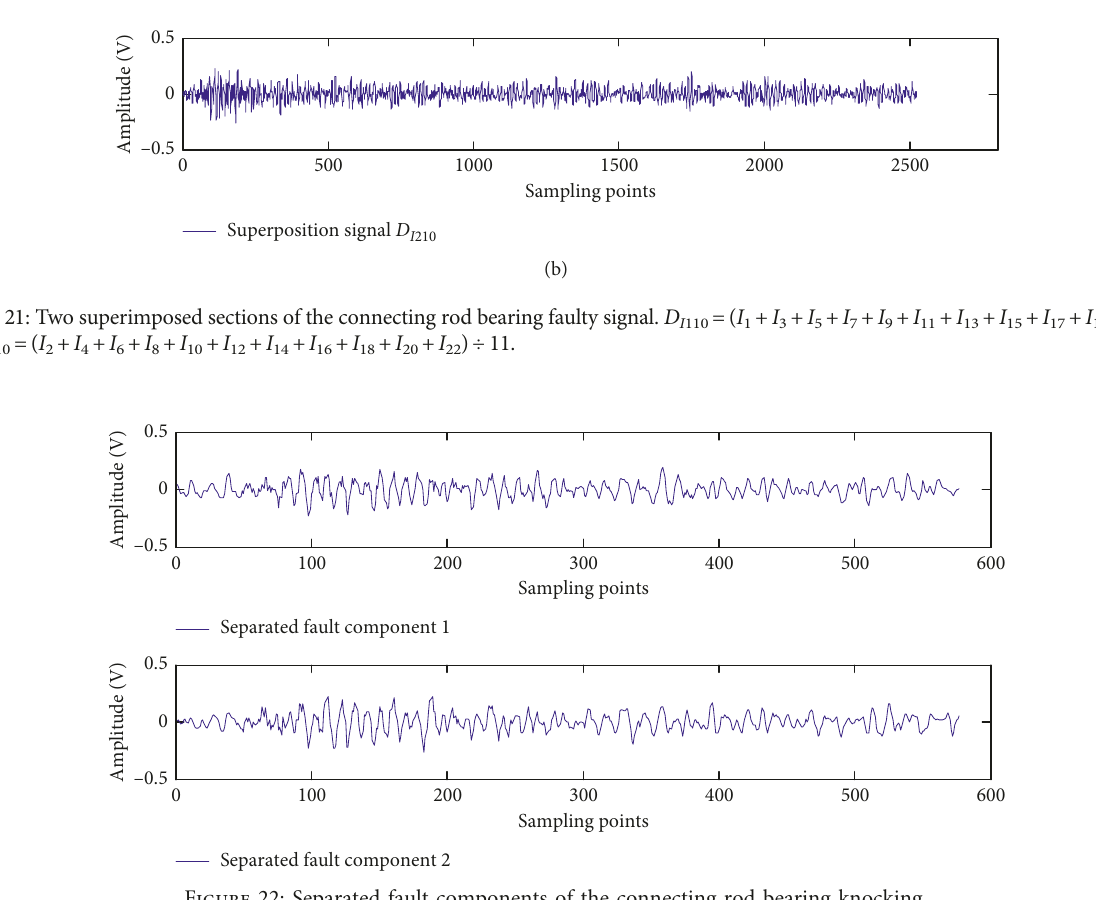
Figure 22: Separated fault components of the connecting rod bearing knocking.